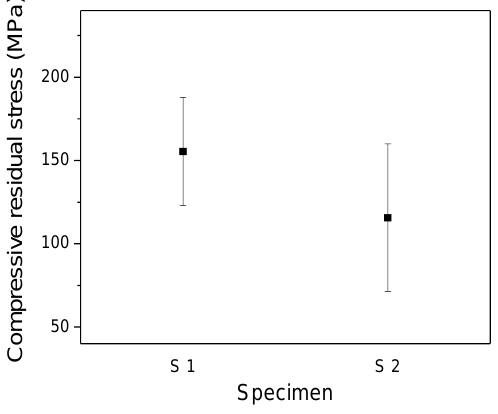
Figure 3. Residual stress of the S specimens measured by instrumented indentation testing (IIT).